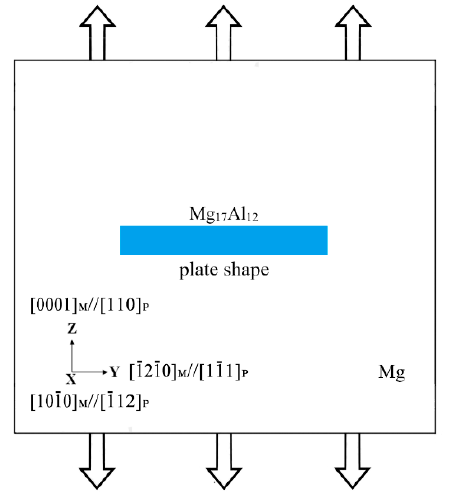
Figure 1. Initial schematic model of the single-crystal magnesium with a precipitate.